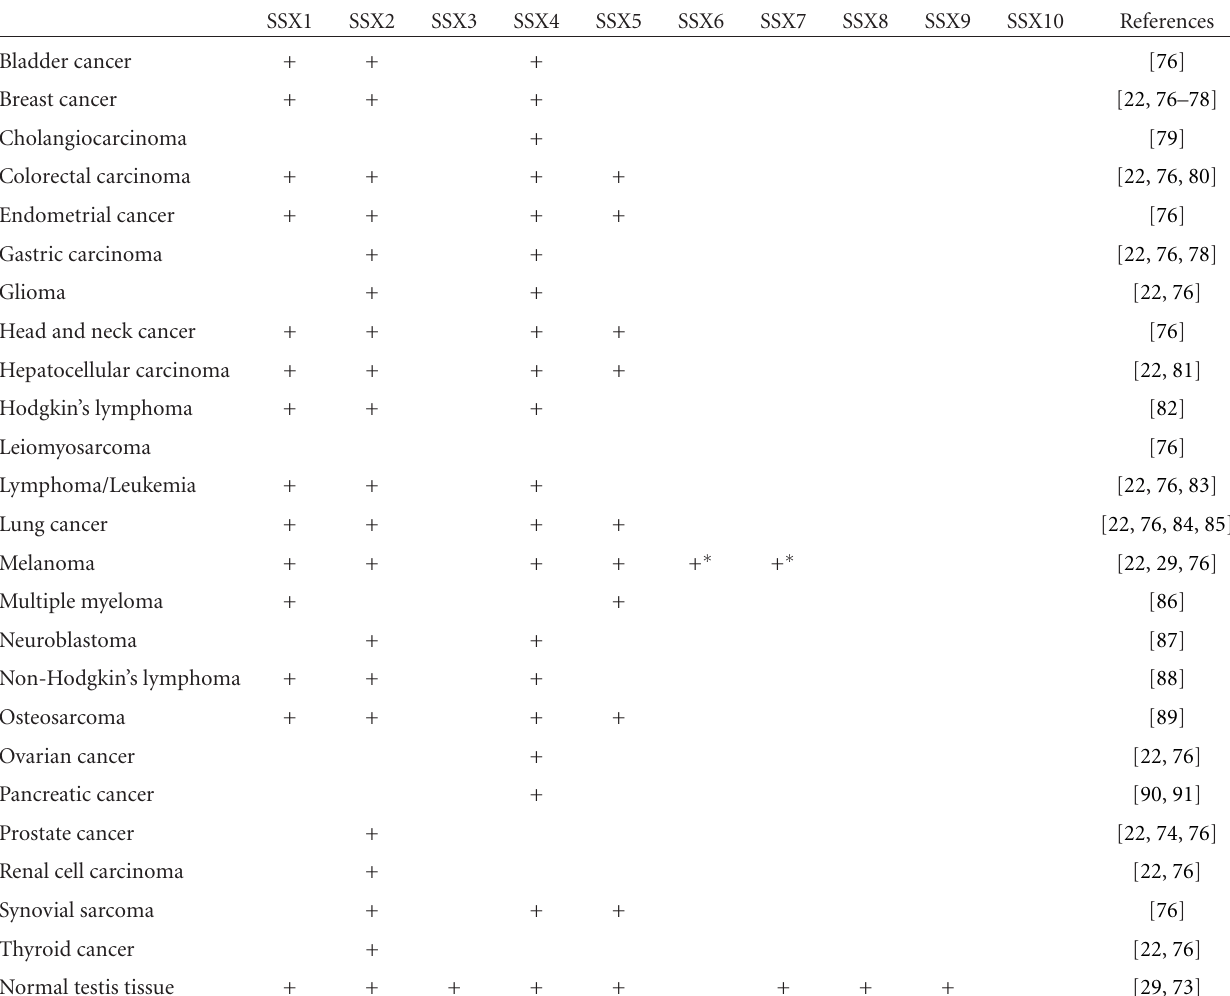
Table 2: Expression of SSX family members in cancers of di ff erent histological types. The expression of SSX family members 1–10 are shown for 24 cancers of varying histological origin and in normal testis tissue. “+” indicates that the presence of SSX mRNA or protein has been detected in these tumor